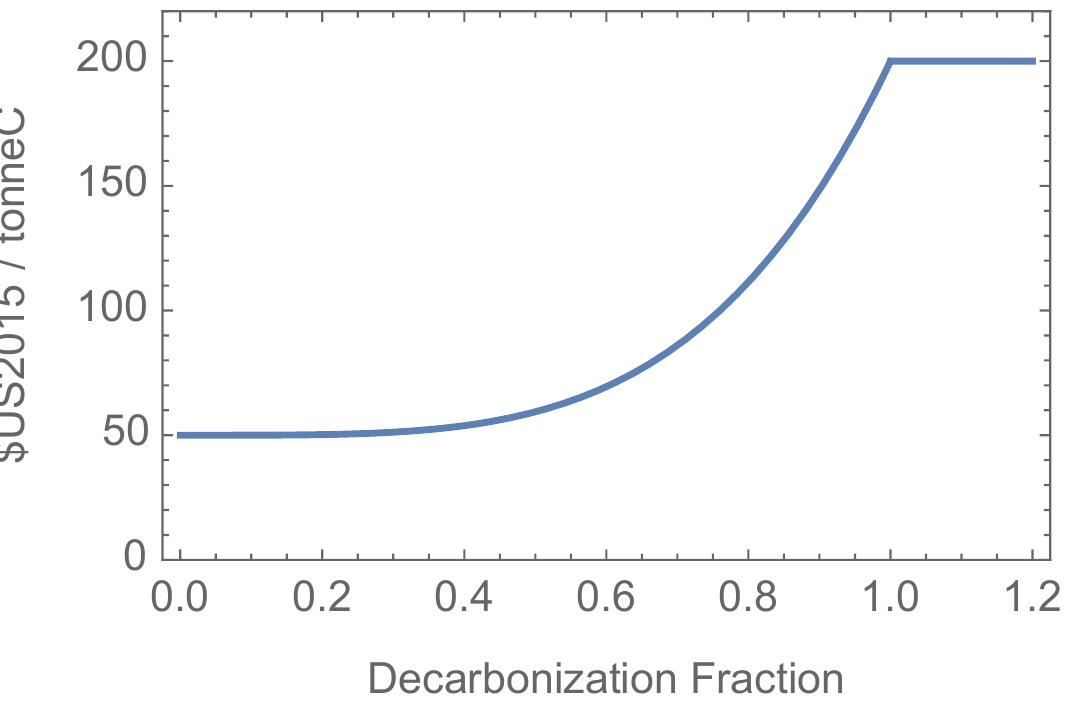
Figure 4. Average cost per metric ton of energy decarbonization as a function of decarbonization